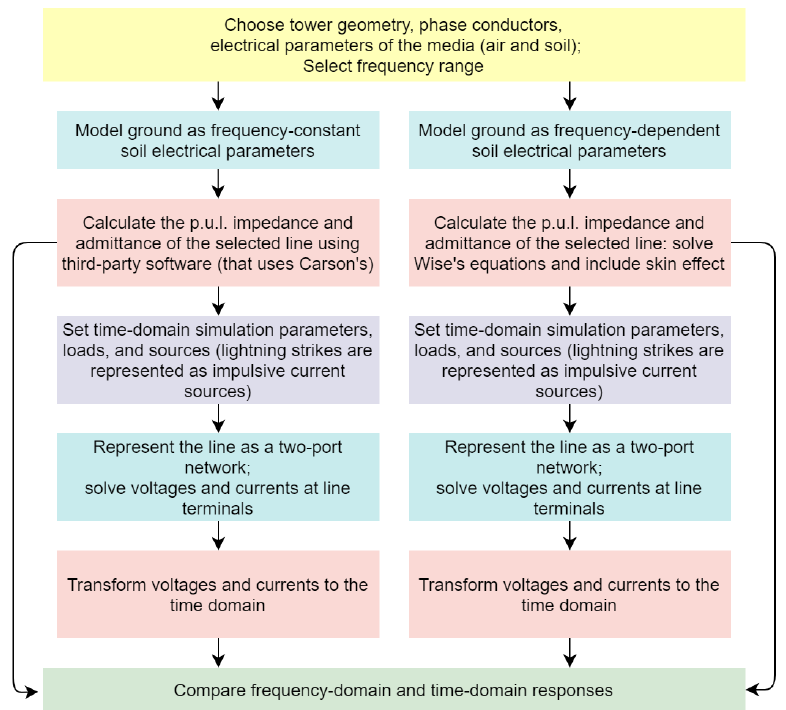
Figure 5. Procedure to compute the frequency-domain and time-domain